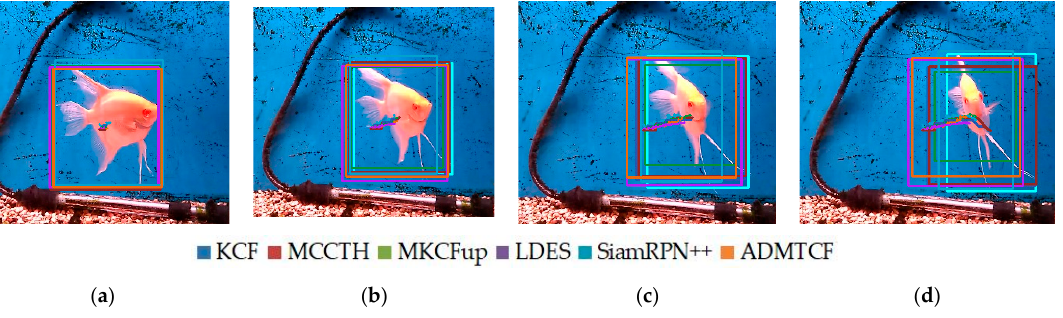
Figure 10. The experimental results of the scenario 2 video with deformation: ( a ) the 15th frame of the video; ( b ) the 38th frame of the video; ( c ) the 49th frame of the video; ( d ) the 58th frame of the video.